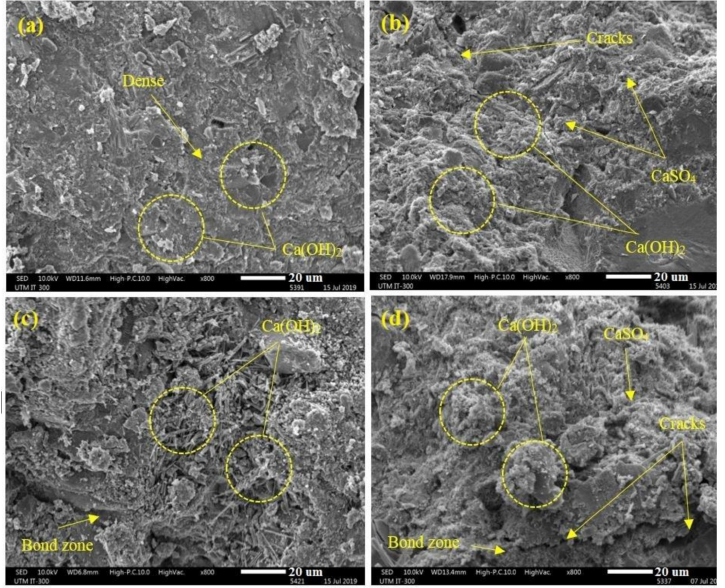
Figure 7. SEM micrographs of the ( a ) GBFS before ( b ) GBFS after ( c ) RF5 before and ( d ) RF5 after exposed to 10% of MgSO 4 solution for 365